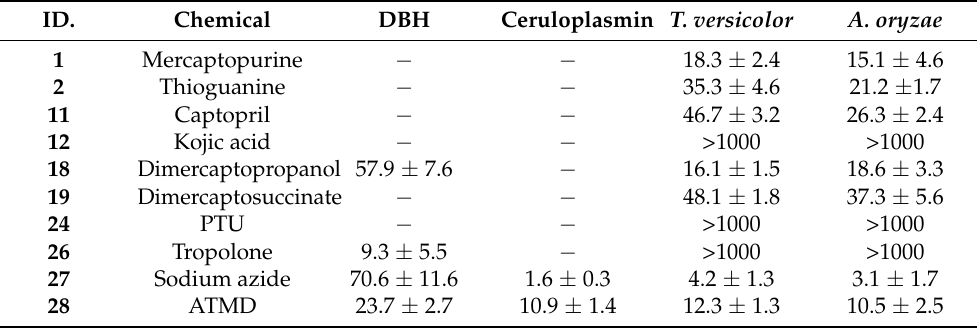
Figure 3. Representative graphs showing concentration-dependent inhibition profiles of test molecules for T. versicolor (black) and A. oryzae (red) laccases. The activities are scaled to have a relative value of 0–1 for 1 . mercaptopurine, 2 . thioguanine, 11 . captopril, 18 . dimercaptopropanol, 19 . dimercaptosuccinate, and 12 . kojic acid. The enzyme activity without inhibitor is adjusted as 1 for 1 − 11 . For 12 , the raw values were included for clarity. Table 1. Quantified inhibitory constants ( K i ) of the tested compounds against DBH, ceruloplasmin, and laccases from T. versicolor and A. oryzae